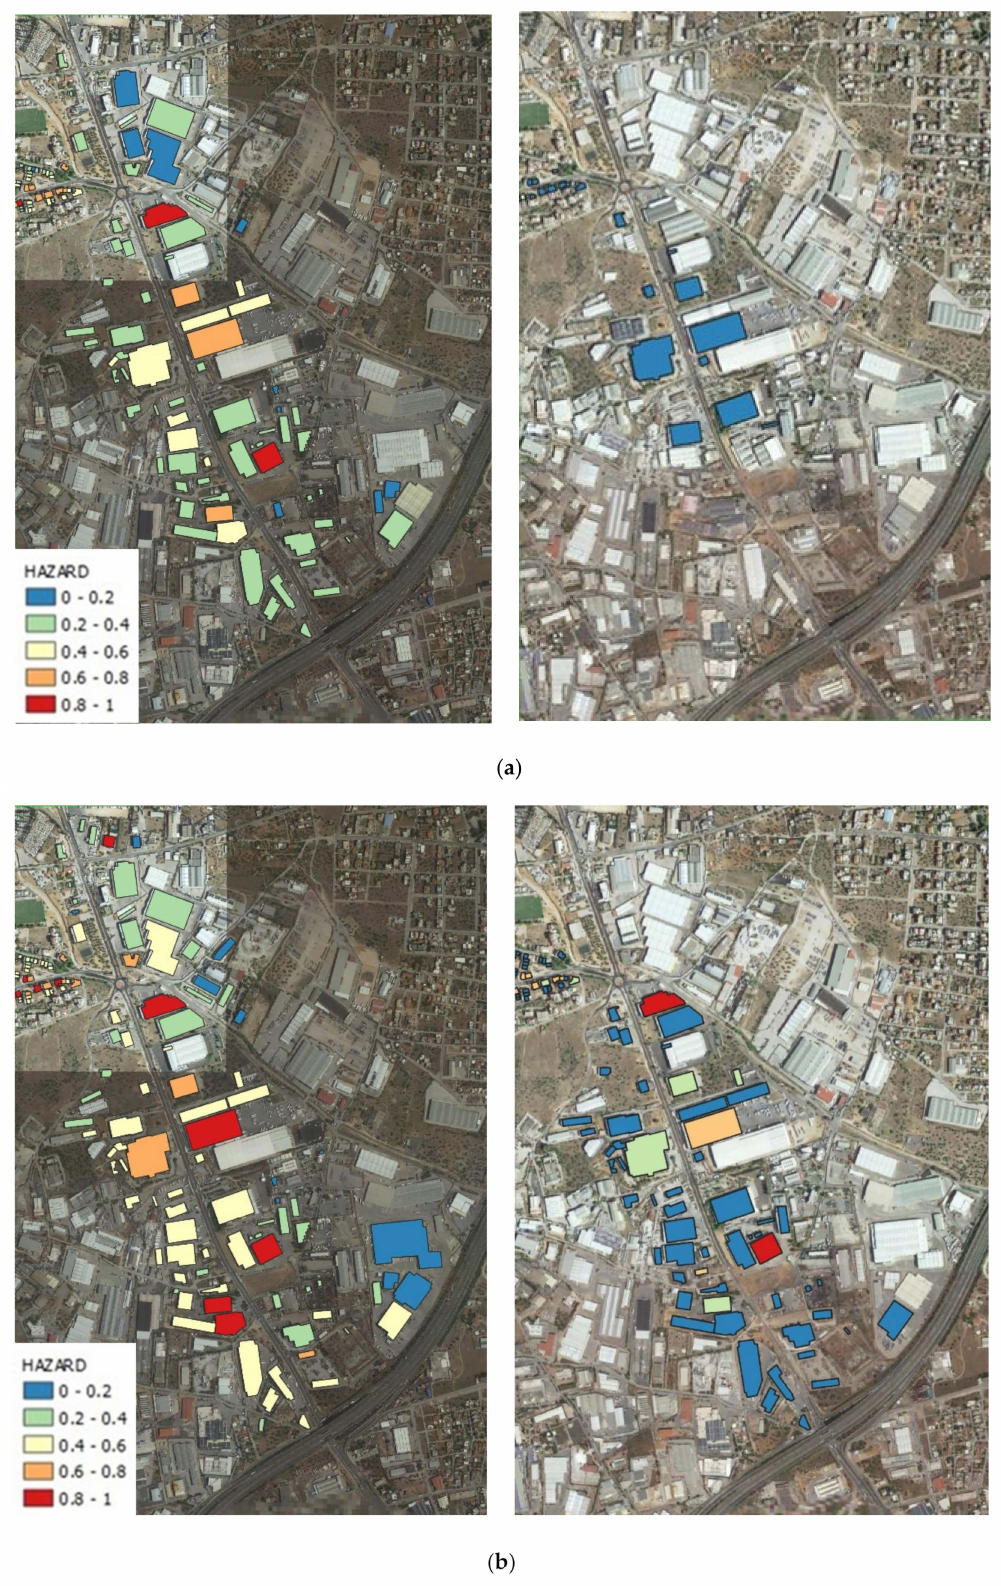
Figure 10. Flood hazard (H) in the industrial area for 4 indicative scenarios: ( a ) Scenarios S20-06 ( left ) and W20-06 ( right ) for T = 20 y and t = 6 h. ( b ) Scenarios S200-18 ( left ) and W200-18 ( right ) for T = 200 y and t = 18